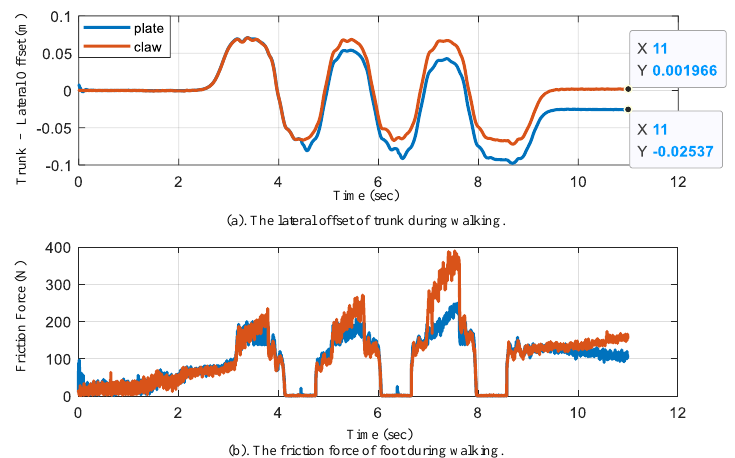
Figure 13. A humanoid robot walks with two different feet (flat foot and foot with bionic mechanism) in a simulation. We compare the lateral offset of the trunk and the friction force of the foot: ( a ) the lateral offset of trunk; ( b ) the friction force of the